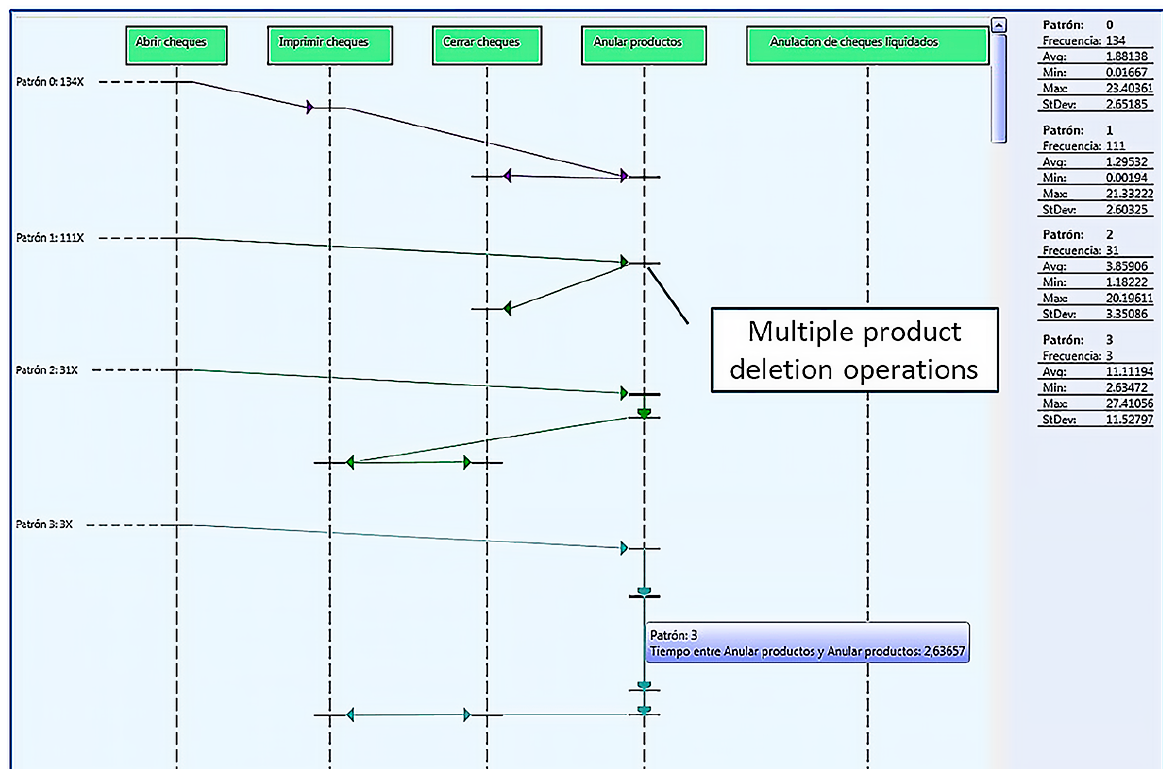
Figure 16. Sequences with product deletions using credit cards.